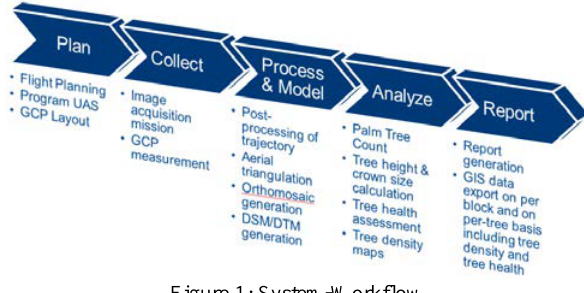
Figure 1: System-Workflow